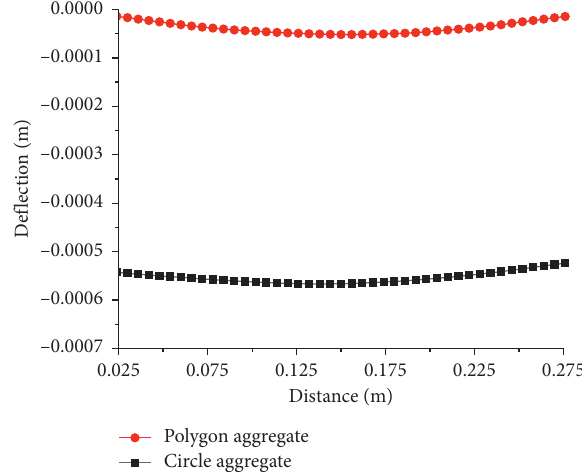
Figure 10: Deflection of the lower boundary of the RC